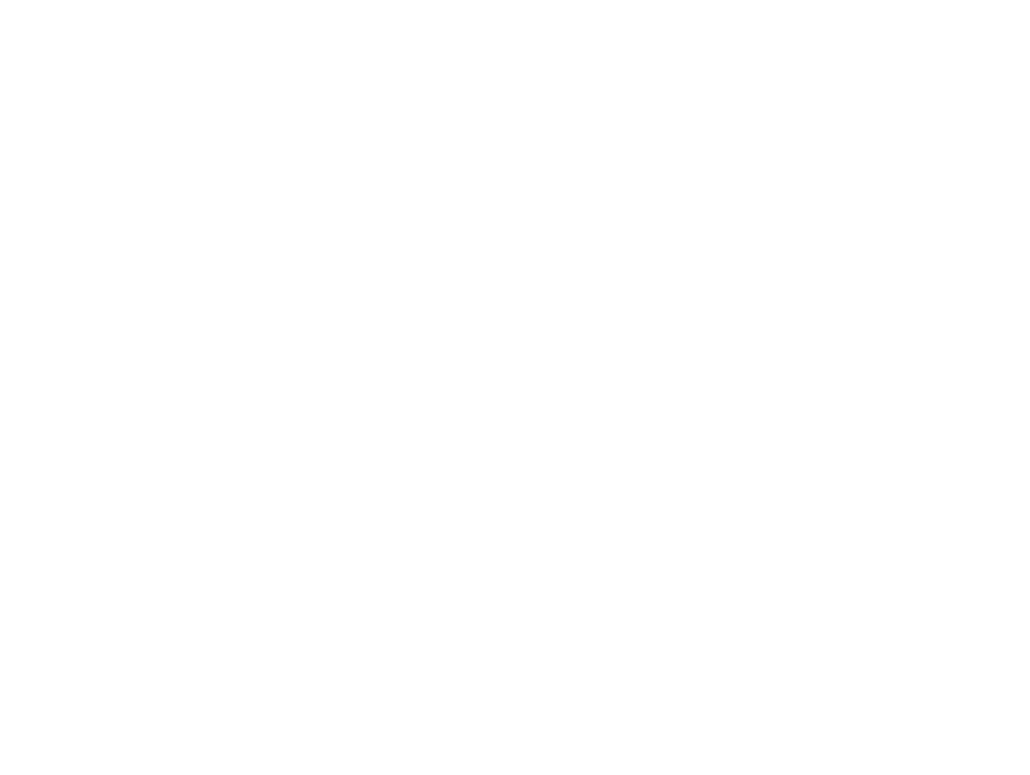
Frontiers in Surgery |